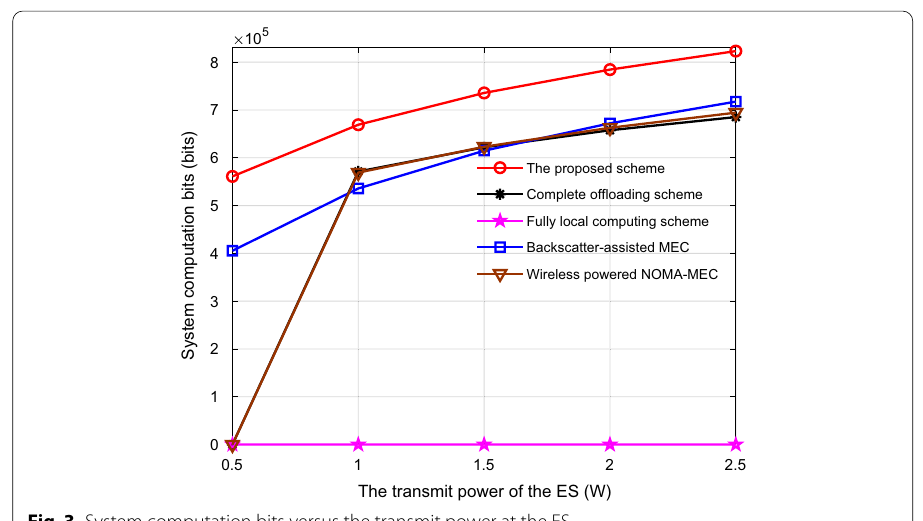
Fig. 3 System computation bits versus the transmit power at the